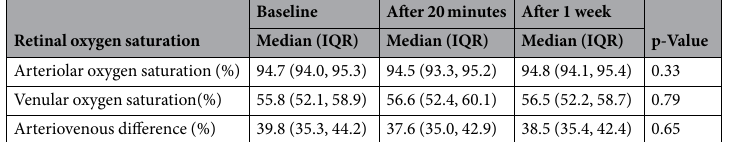
Retinal oxygen saturation